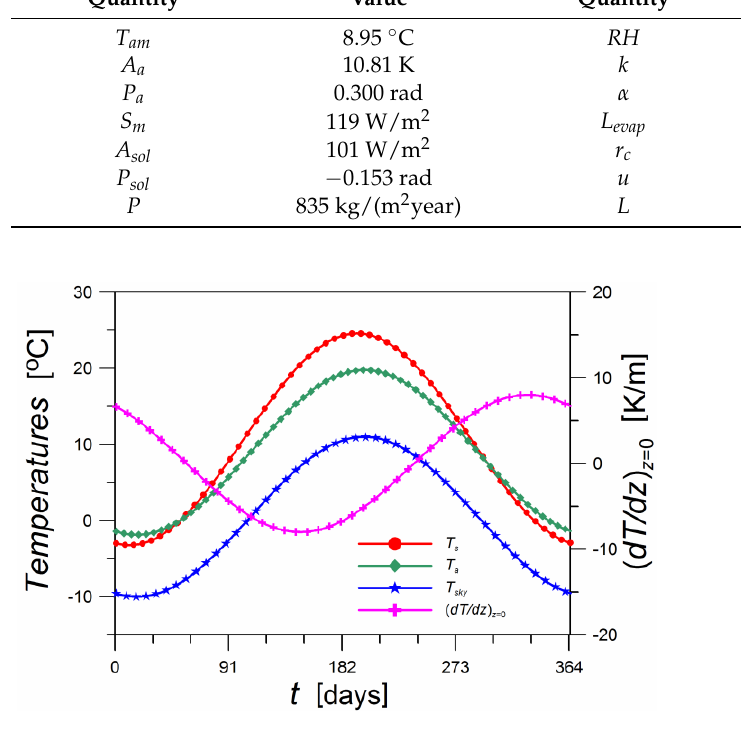
Figure 4. Annual temperature courses: air, ground surface, the sky and the gradient of the ground temperature on its surface.